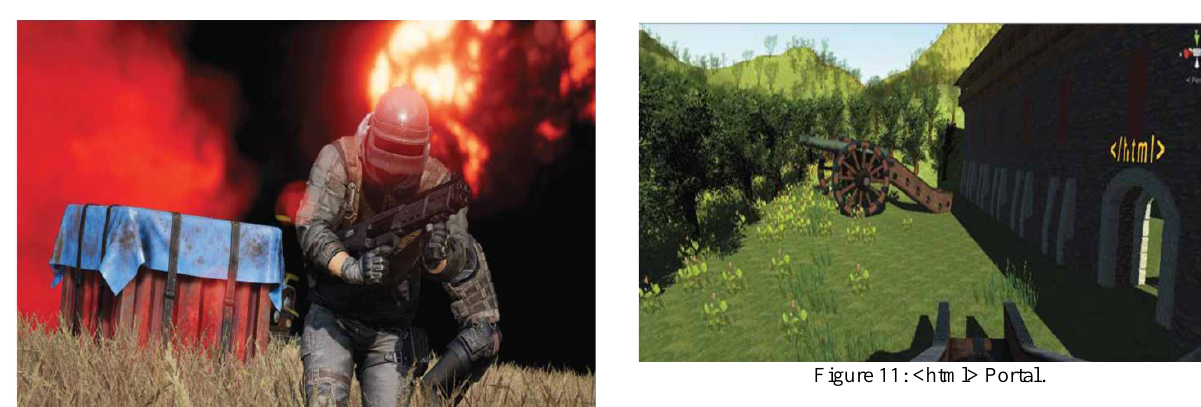
Figure 7: killers game example.